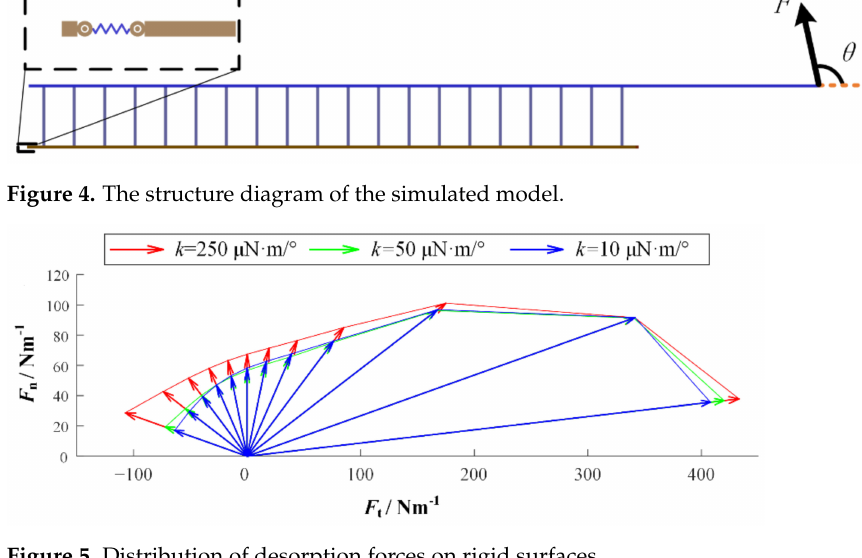
Figure 5. Distribution of desorption forces on rigid surfaces.